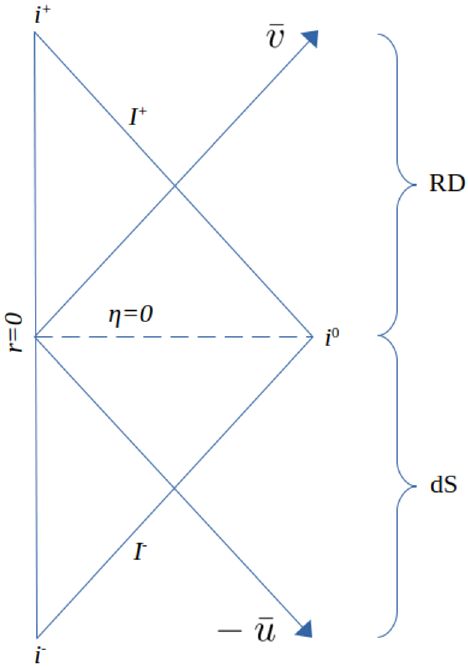
Figure 1 . Penrose diagram of a dS → RD